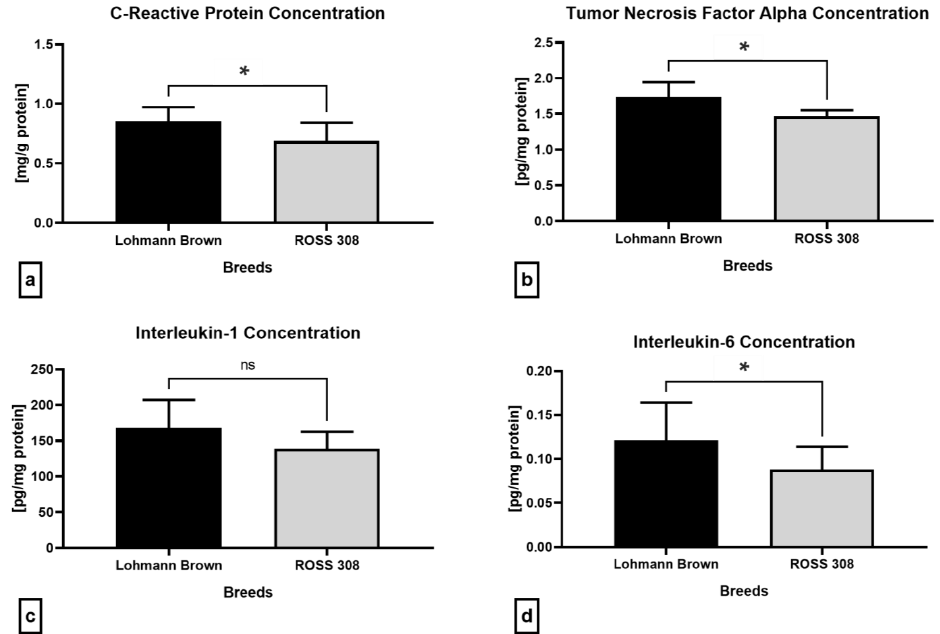
Figure 6. Immunological profile of semen samples collected from Lohmann Brown and ROSS 308 roosters, represented by the C-reactive protein ( a ), tumor necrosis factor alpha ( b ), interleukin-1 ( c ) and interleukin-6 ( d ). Mean ± SD. Significant (*) if p < 0.05. ns — non-significant.